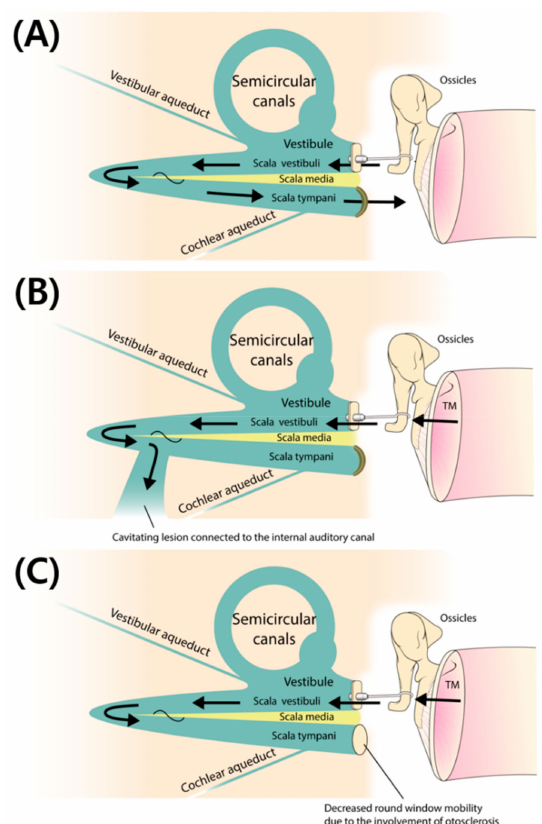
Figure 2. ( A ) Restoration of air conduction (AC) energy and near-normalized sound conduction in a subject with otosclerosis after stapedotomy. ( B ) Even after restoration of AC energy at the